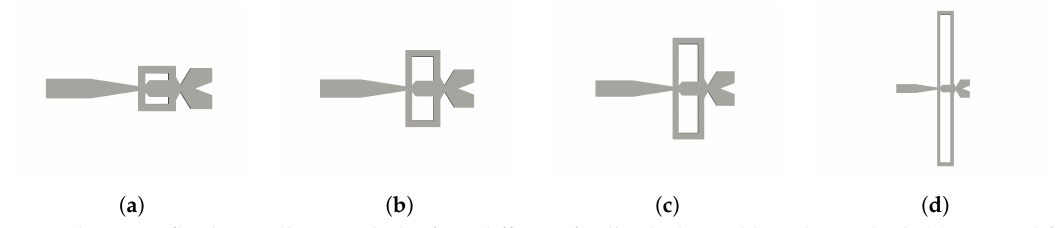
Figure 2. Baseline case fluidic oscillator with the four different feedback channel lengths studied. ( a ) Original feedback channel length L; ( b ) feedback channel length 2L; ( c ) feedback channel length 3L; ( d ) feedback channel length 9L.